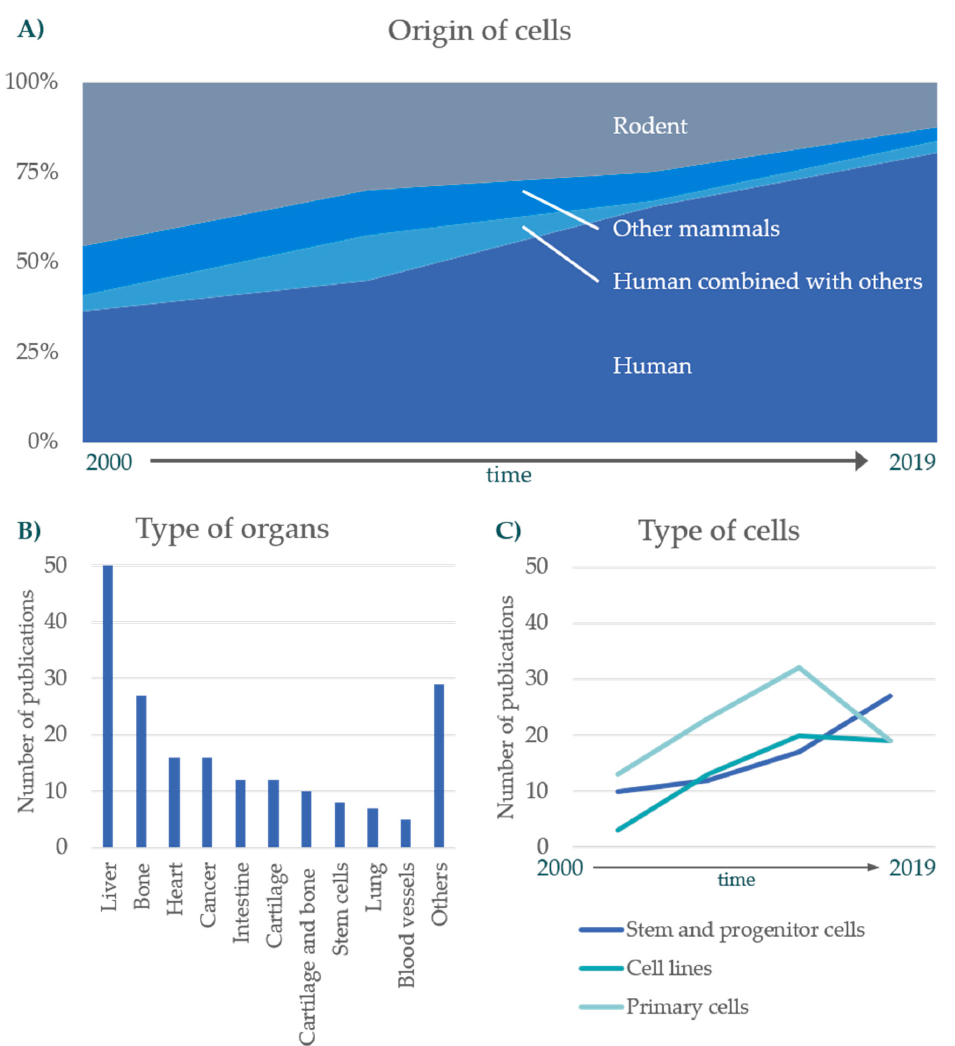
Figure 8. Distribution of the cells used in the publications under study with respect to the origin of the cells ( A ), the target tissues / organs ( B ), and the type of cells ( C ). Others: bladder, placenta, muscle, endometrium, skin, vaginal epithelium, retina, kidney, pancreas, nerves, connective tissue, and brain. Number of publications: 192.